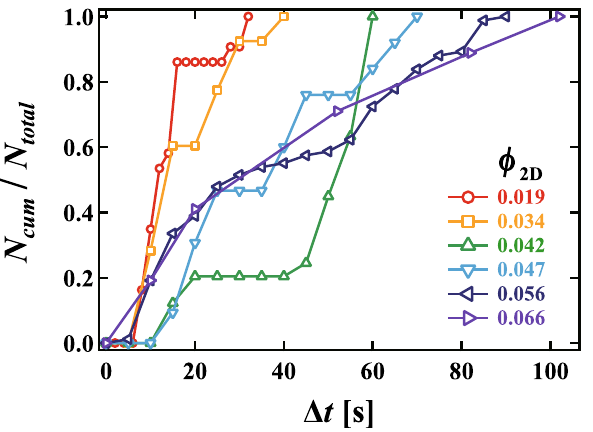
Figure 2. The cumulative number of rearranged bubbles N cum / N total during the rearrangement process as a t t s , where N total is the total number of rearranged bubbles during the rearrangement function of time (cid:31) t = − process and t s is the time when the effect of the solution injection becomes negligible. Red, orange, green, light blue, navy blue and purple lines correspond to φ 2 D = 0.019, 0.034, 0.042, 0.047, 0.056 and 0.066, respectively. It is found that N cum increases discontinuously for φ 2 D = 0.019, 0.034, 0.042 and 0.047, whereas N cum increases continuously for φ 2 D = 0.056 and 0.066.